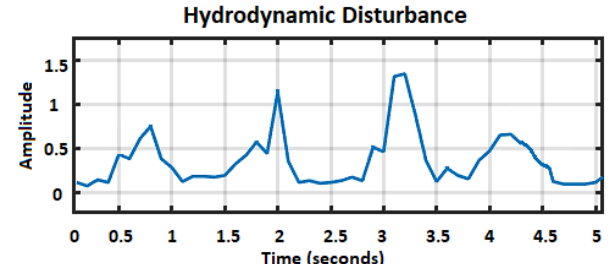
Figure 12. Adaptive structure for hybrid LQR.